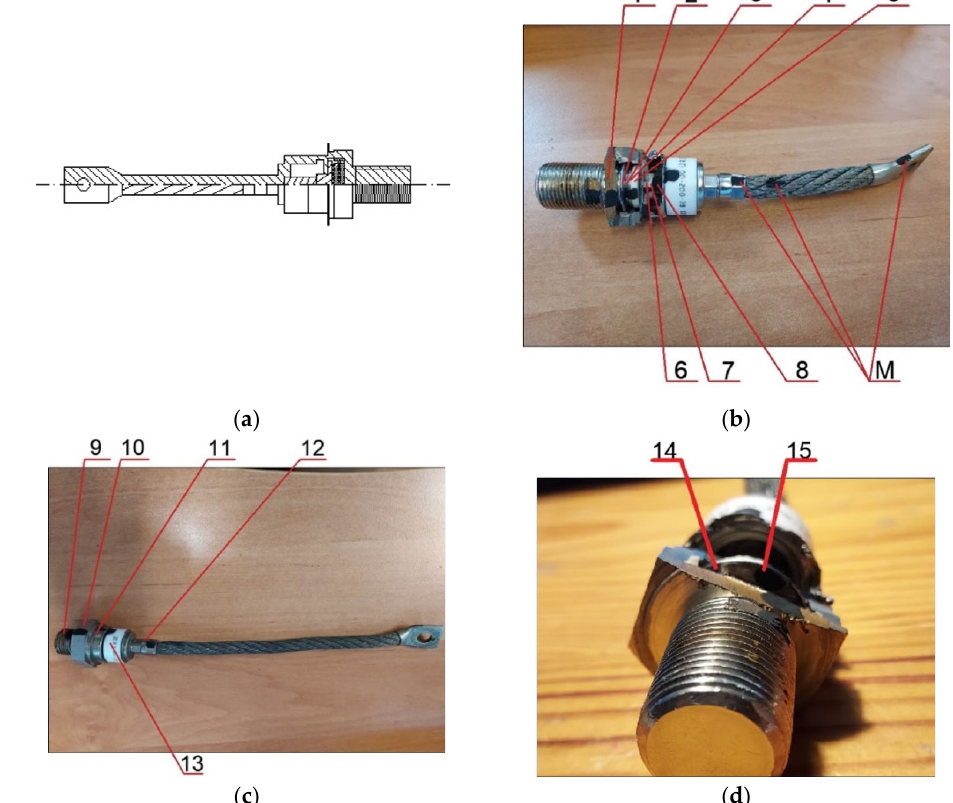
Figure 1. Diode D00 ‐ 250 ‐ 10 used in the works: ( a ) technical drawing, ( b ) view of the opened diode, ( c ) view of the closed diode, ( d ) view of the semiconductor junction, 1–16—surfaces observed, M—sample markers.